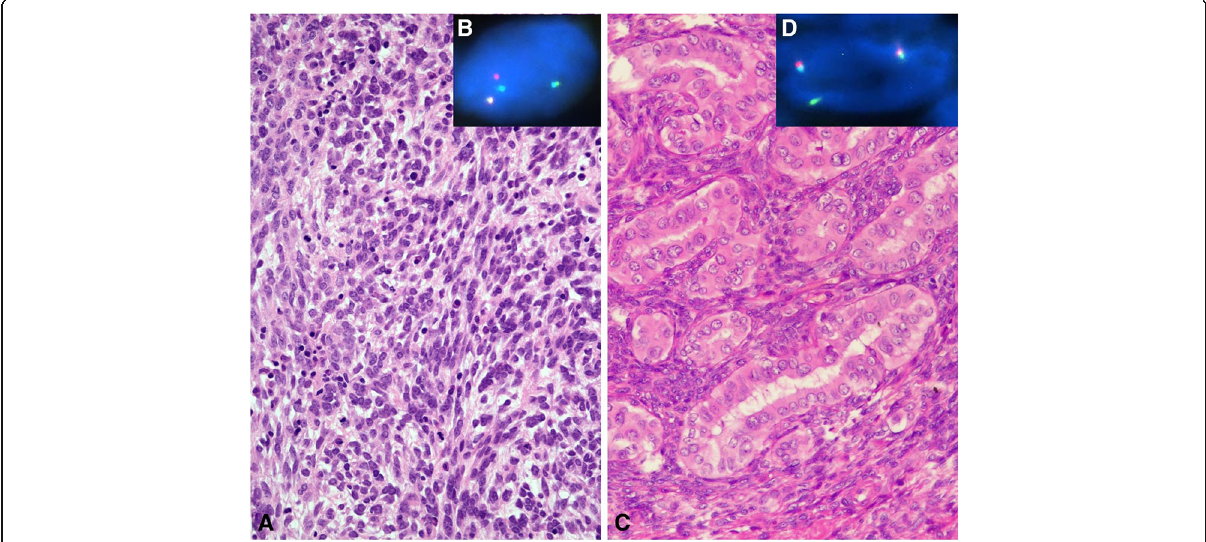
Fig. 1 Hematoxylin-eosin (H&E) staining and FISH analysis of two SS patients. a H&E staining of a monophasic, spindle cell SS ( case no. 6 ). b The SS18-SSX2 fusion is indicated by one separate green signal, one separate orange signal and a blue signal in close proximity of the separated green signal using FISH method. c H&E staining of a biphasic SS ( case no. 15 ). d The SS18-SSX1 fusion is indicated by one separate orange signal co-localizing with one blue signal using